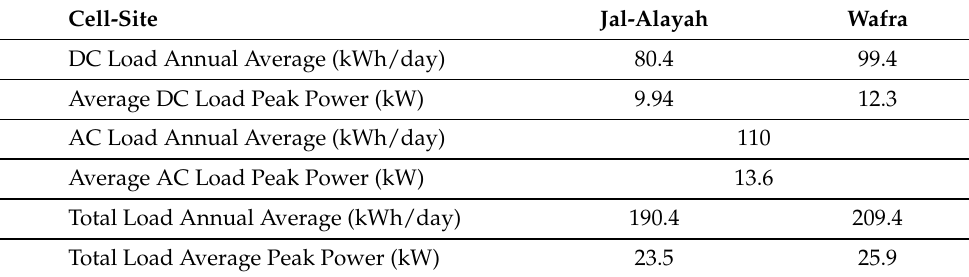
Table 2. Summary of load profiles at the Jal-Alayah and Wafra Cell-Sites.